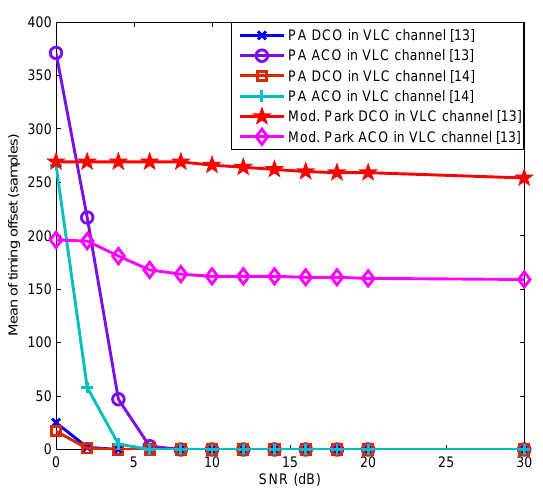
Figure 4. Mean of the timing offset in DCO-OFDM and ACO-OFDM using 1000 frames with N = 256, U = 5, cp = N /16, and 4-QAM.